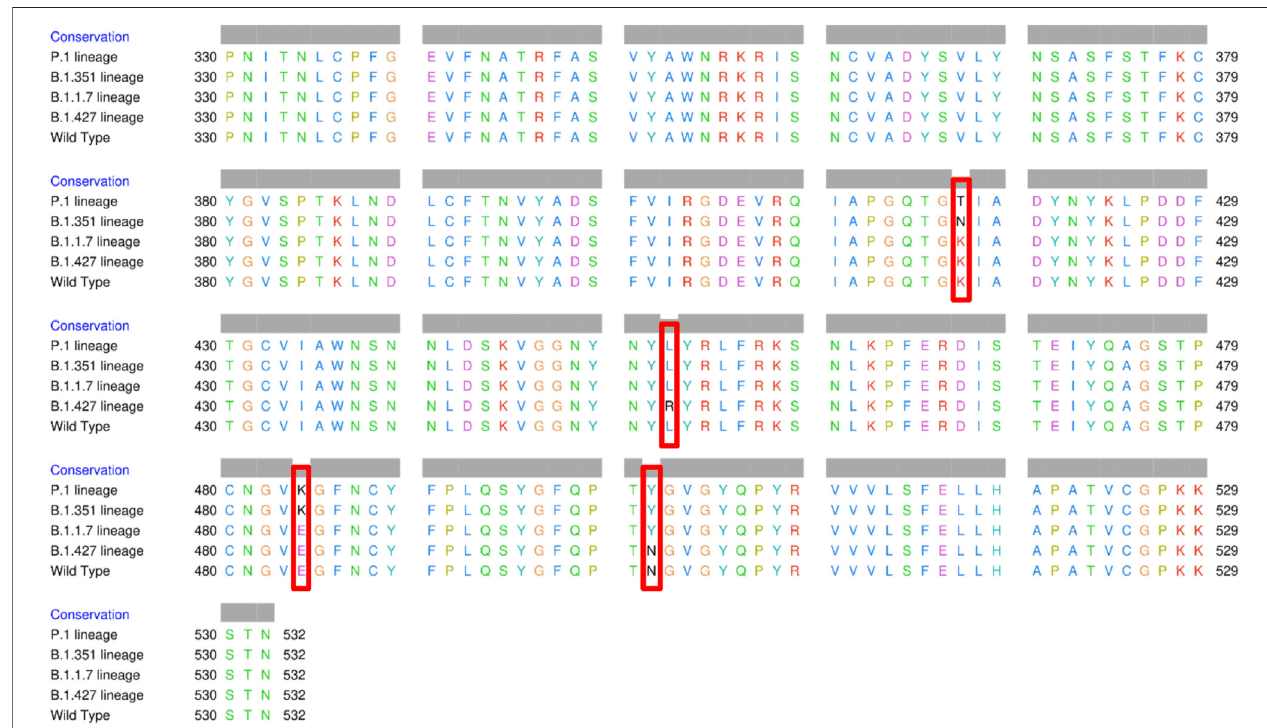
FIGURE 3 | Multiple sequence alignment of the amino acid sequences ofwild type (WT) SARS-CoV-2 spike receptor-binding domain (RBDs) and the four variants BR, SA, United Kingdom, and US.